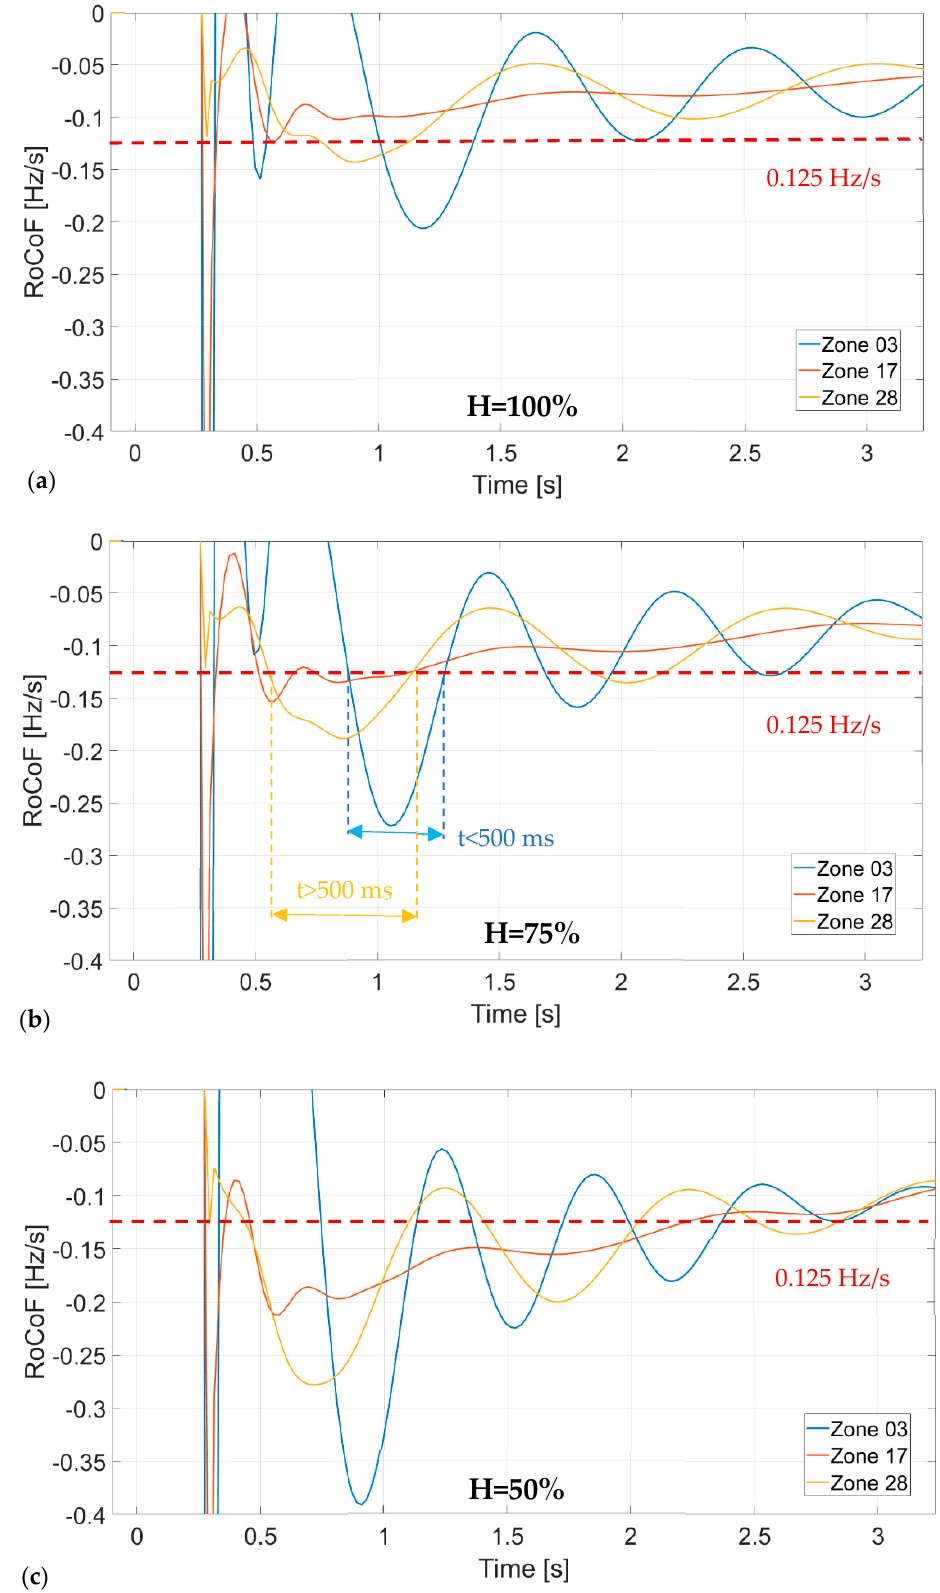
Figure 16. RoCoF for the three zones of interest in the reduced model, for a 1000 MW infeed loss with three levels of inertia (100%, 75%, and 50%).